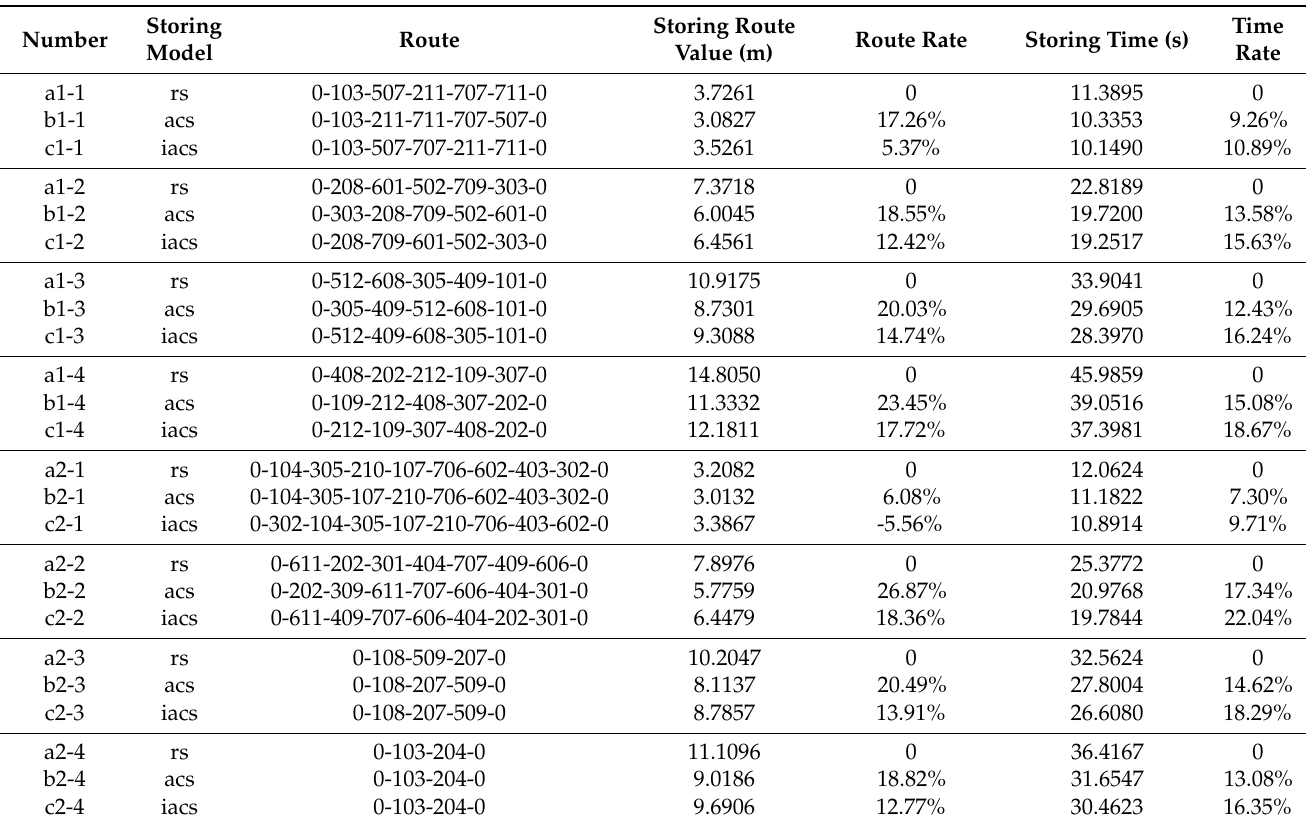
Table 6. Simulation results of different storing